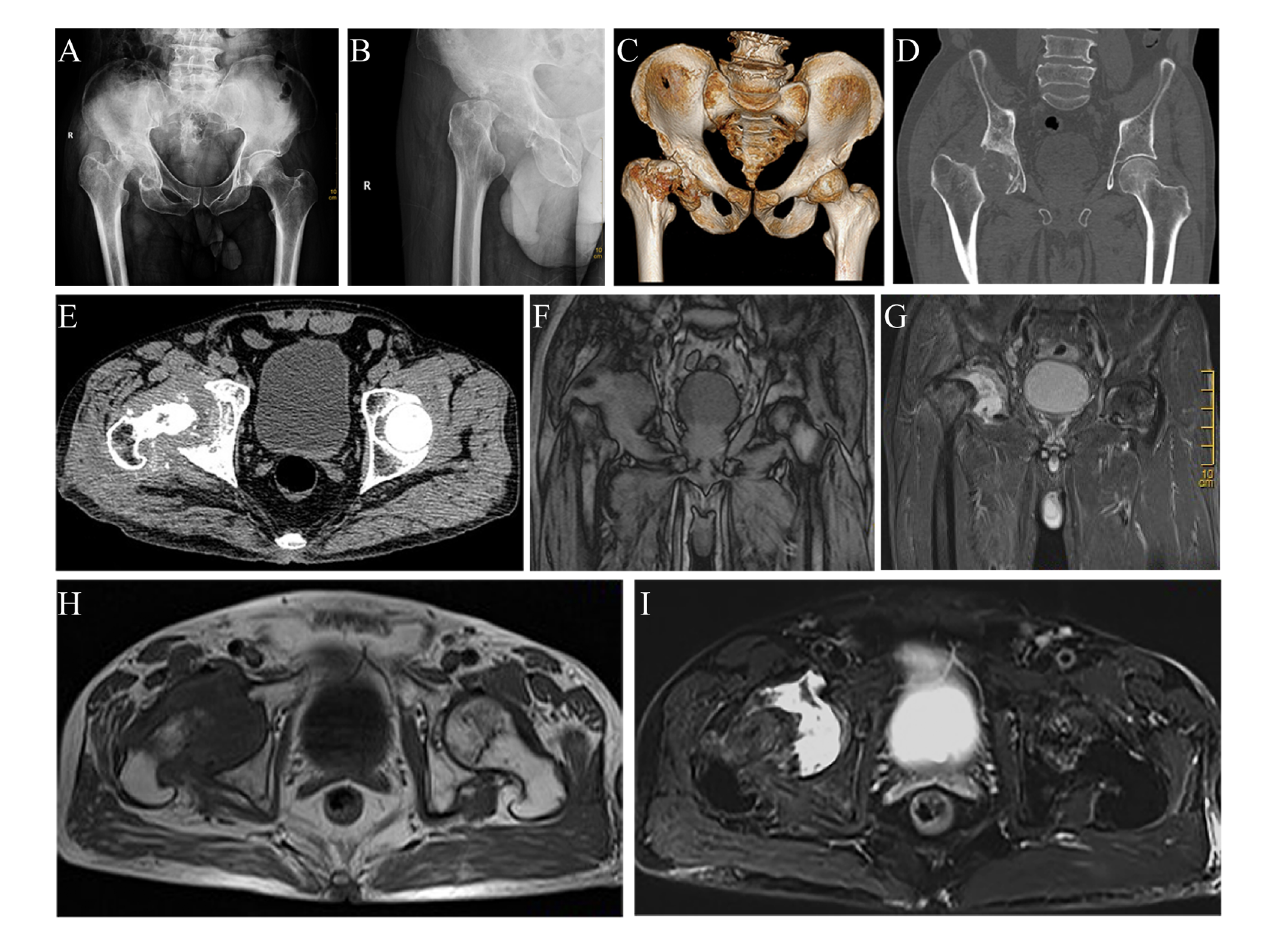
FIGURE 1 Radiograph images, 3D reconstruction image, CT scan images and MRI images of the hip joint revealing massive osteolysis in the right femoral head, femoral neck, and acetabulum. Anteroposterior ( A ) and lateral ( B ) radiographs of the hip joint show massive osteolysis in the right femoral head, femoral neck, and acetabulum. The 3D reconstruction image ( C ), coronal ( D ), and horizontal ( E ) CT scan images con fi rm the complete disappearance of the right femoral head and destruction of the femoral neck and acetabulum. Coronal ( F ) and horizontal ( H ) T1-weighted images show extensive hypointense osteolytic lesions involving the right femoral head, femoral neck, and acetabulum. Coronal ( G ) and horizontal ( I ) fat-suppressed T2-weighted images indicate extensive hyperintensity osteolytic